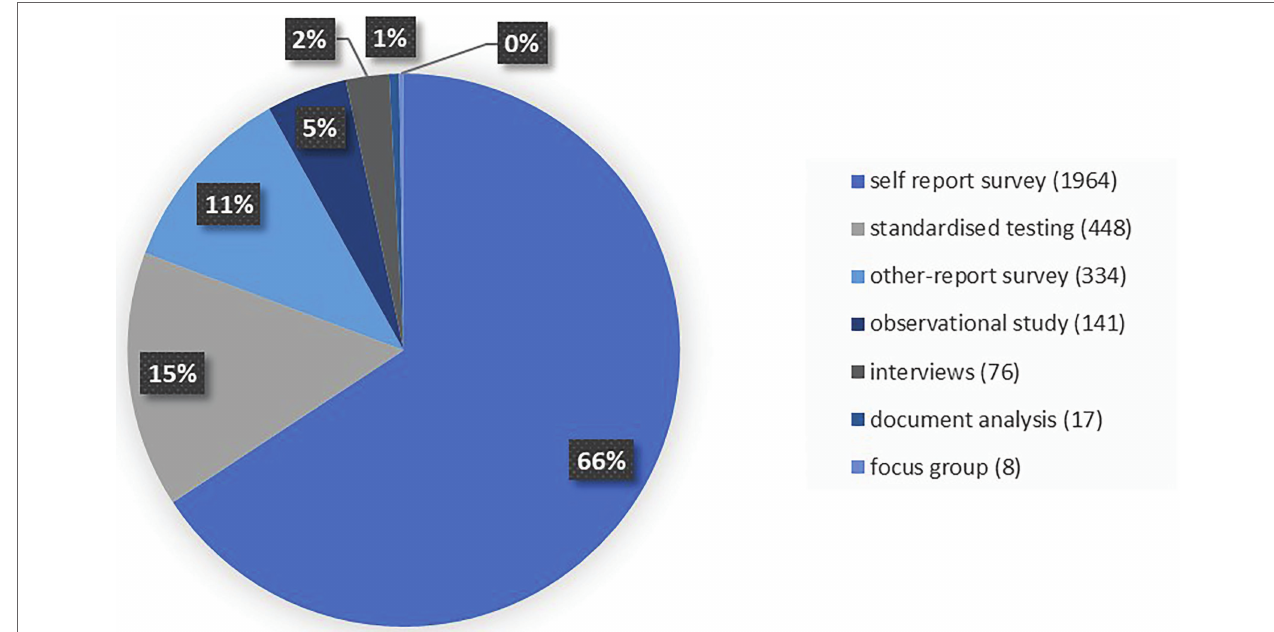
FIGURE 4 | Types of research tools used in positive education,